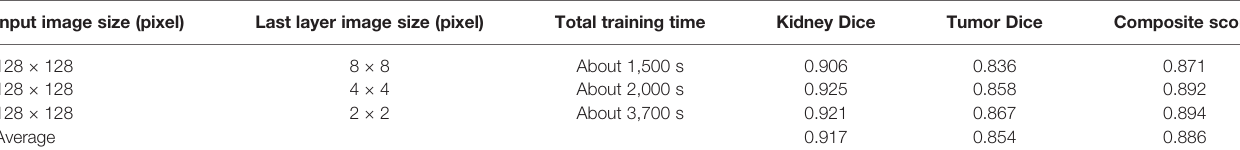
TABLE 2 | Fine segmentation based on R2AttU-Net model.